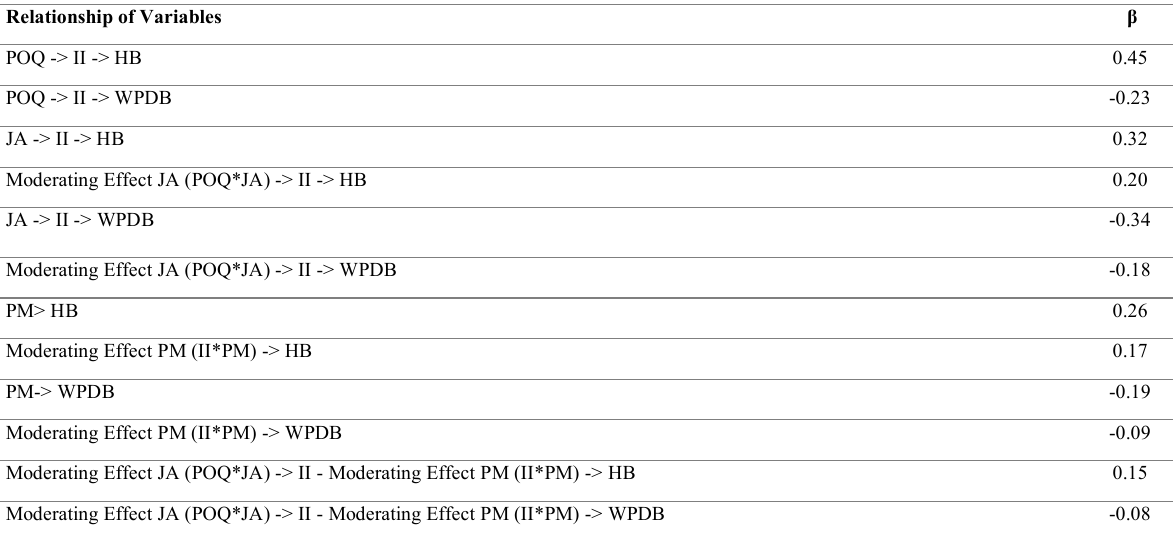
Table 4: Indirect